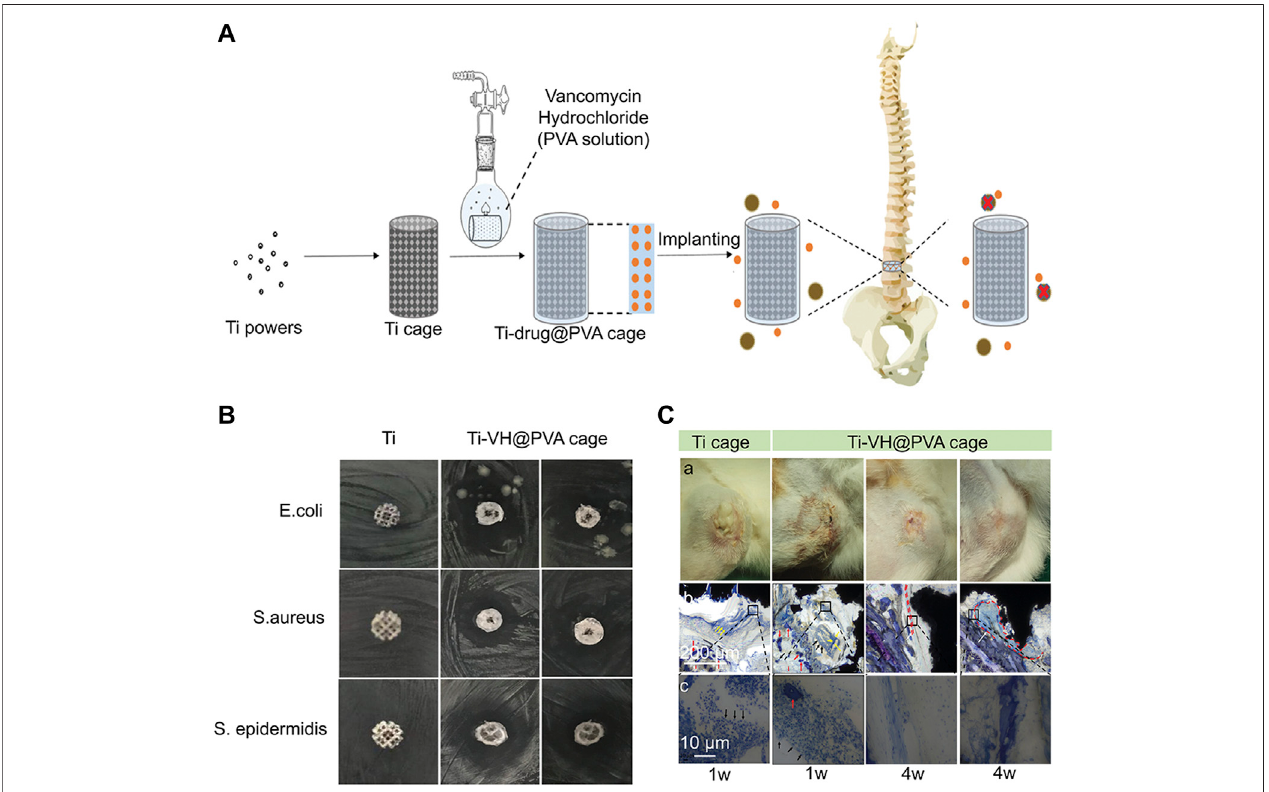
FIGURE 6| A 3D-printed titanium cage combined witha drug-releasingsystem for in situ drug release and bactericidal action (LiY et al., 2020). (A) The schematic illustration of a 3D-printed titanium cage coated with PVA-vancomycin for preventing surgical site infections (Berbel, Banczek et al.) after spine surgery. (B) Antibacterial evaluation of Ti-VH@PVA cages in vitro . The obvious bacteriostatic circle was observed with regard to Staphylococcus aureus and Staphylococcus epidermidis . (C) Evaluation of Ti-VH@PVA cages for preventing SSIs in vivo . With the extension of time, the in fi ltration of in fl ammatory cells decreased signi fi cantly in Ti-VH@PVA cage. Furthermore,thethicknessofthediscontinuous fi brouscapsulebetweenthetrabecular boneandtheTi-VH@PVAcageincreased. ThisindicatesthatTi-VH@PVA cage has a signi fi cant inhibitory effect on Staphylococcus aureus.